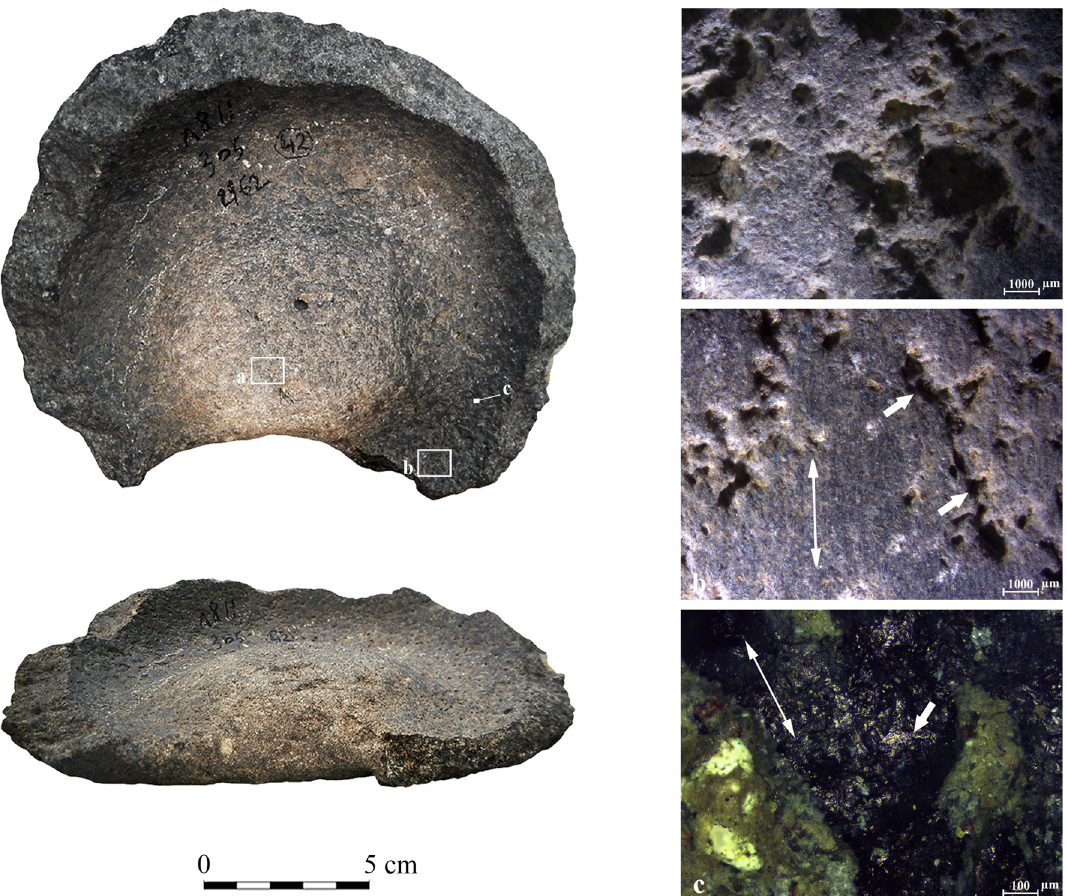
Fig 10. Archaeological vessel YH42 from the Late Chalcolithic site of Yehud. (1) Sinuous surface of the elevated center with small flattened peaks and rounded pits (10x); (2) Surface of the circumferential depression with large plateaus, diffuse rounded recesses marked by arrows, and continuous parallel covering striations, with their orientation marked by a double-headed arrow (10x); (3) Concentrations of developing reticular polish on the protruding surfaces within the circumferential depression, marked by arrows (the orientation of the macro-scale striations marked by a double-headed arrow)